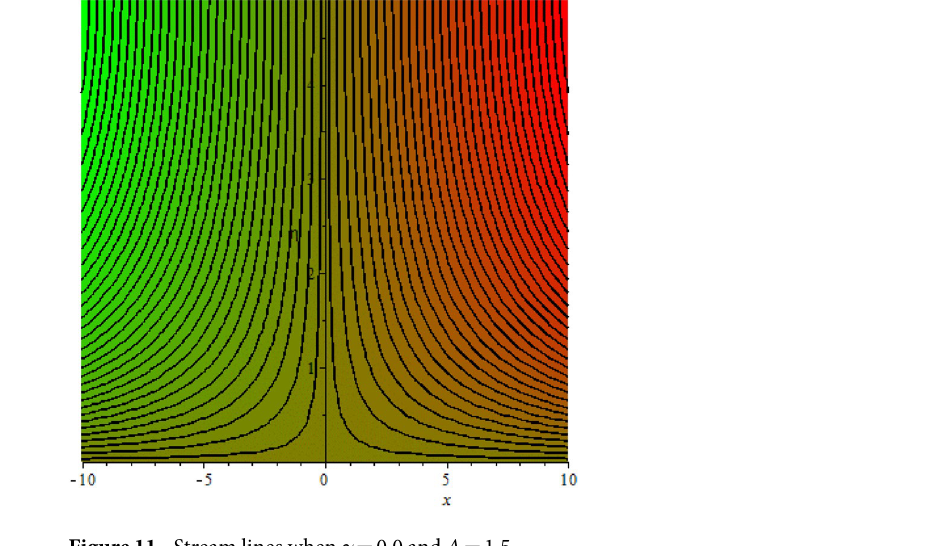
Figure 11. Stream lines when γ = 0.0 and A =